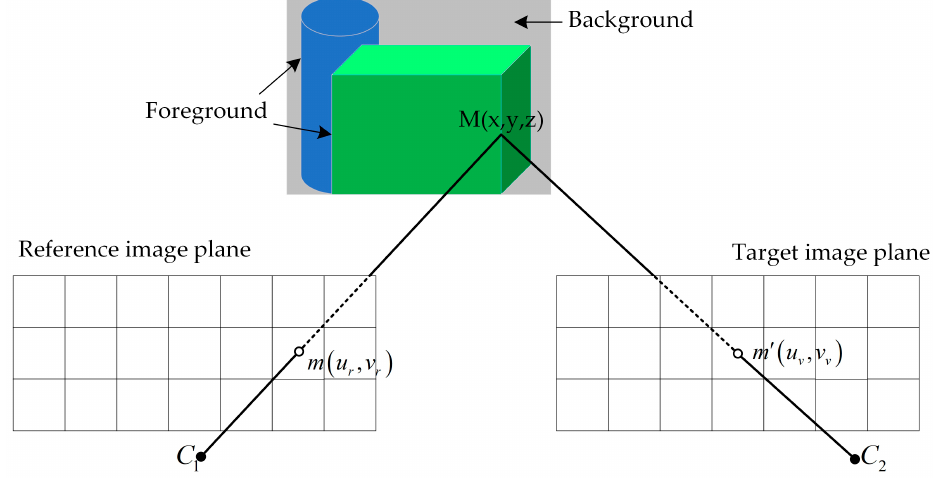
Figure 1. Schematic diagram of 3D warping.